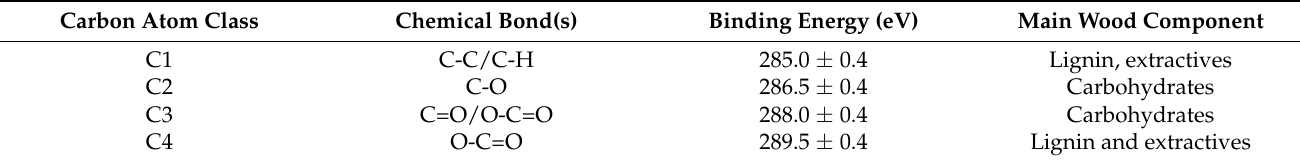
Table 3. Binding energies of different oxidation states of carbon atoms from the X-ray photoelectron spectroscopy (XPS) high-resolution C1s spectra of lignocellulosic materials